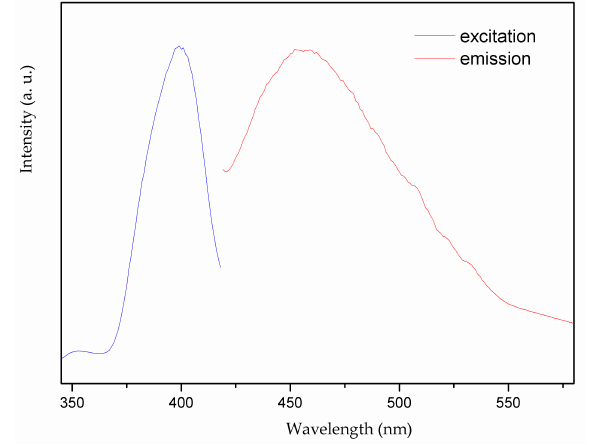
Figure 9. Solid-state photoluminescent spectra of 1 at room temperature.